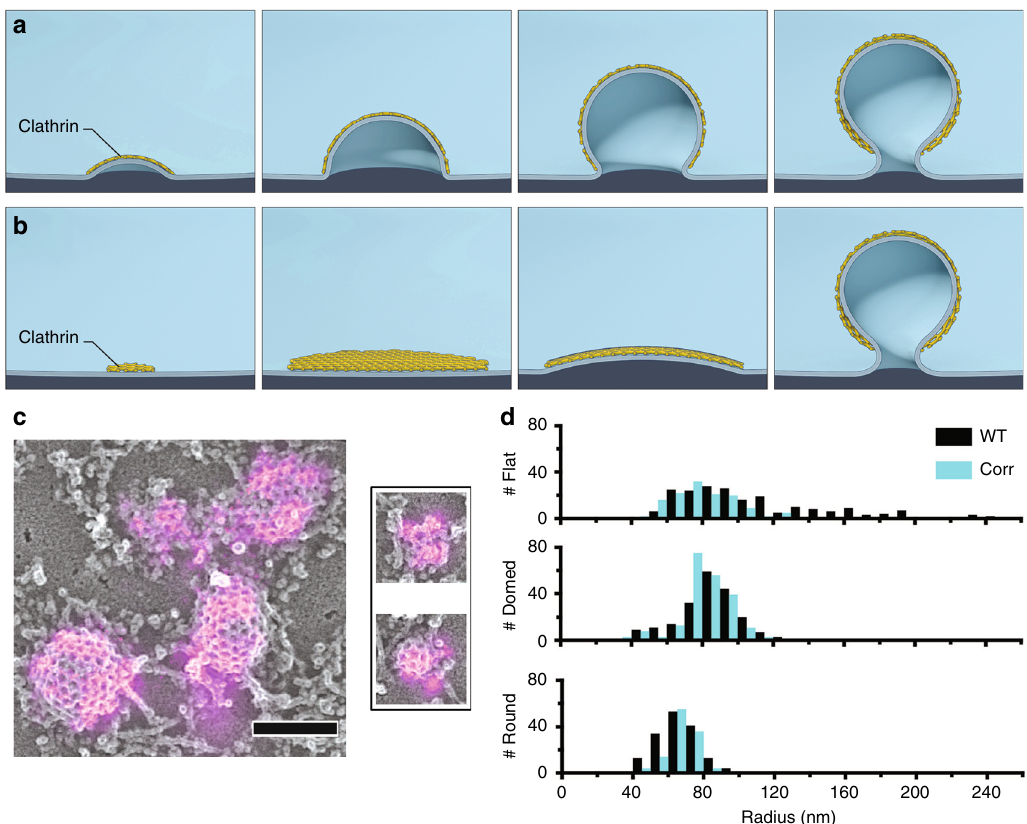
Fig. 1 Mechanisms of membrane bending during CME and clathrin ultrastructure in unroofed SK-MEL-2 cells. a Schematic representation of CME in which membrane bending proceeds with a fi xed radius of curvature during the addition of clathrin subunits. b Representation of CME in which clathrin fi rst assembles into a fl at sheet that remodels into a vesicle. c Correlative dSTORM and platinum-replica TEM images of fl uorescently labeled clathrin (magenta) demonstrate a range of heterogeneous topographies even at the earliest stages of CME; scale bar is 200 nm. d The size distribution observed amongst clathrin structures in WT SK-MEL-2 cells (black) or SK-MEL-2 cells exogenously expressing clathrin light chain for correlative microscopy (blue). The inset shows ratios of average fl uorescence associated with round vs. domed structures and domed vs. fl at structures (SD shown for N = 3 cell